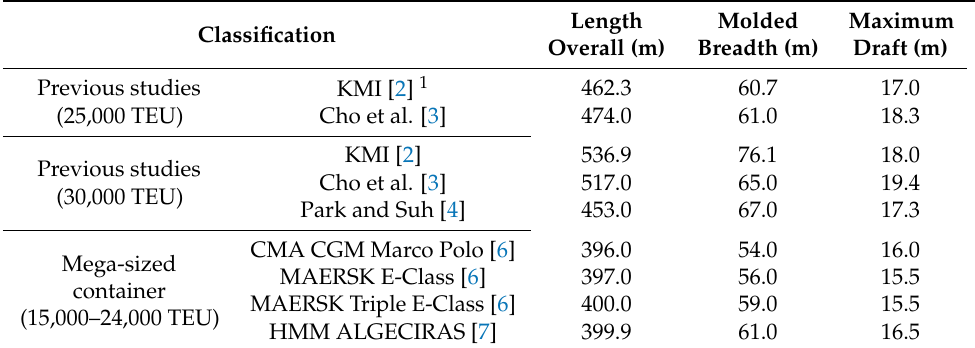
Table 1. Comparison of dimensions reported by previous studies and those of mega-sized container ships currently in